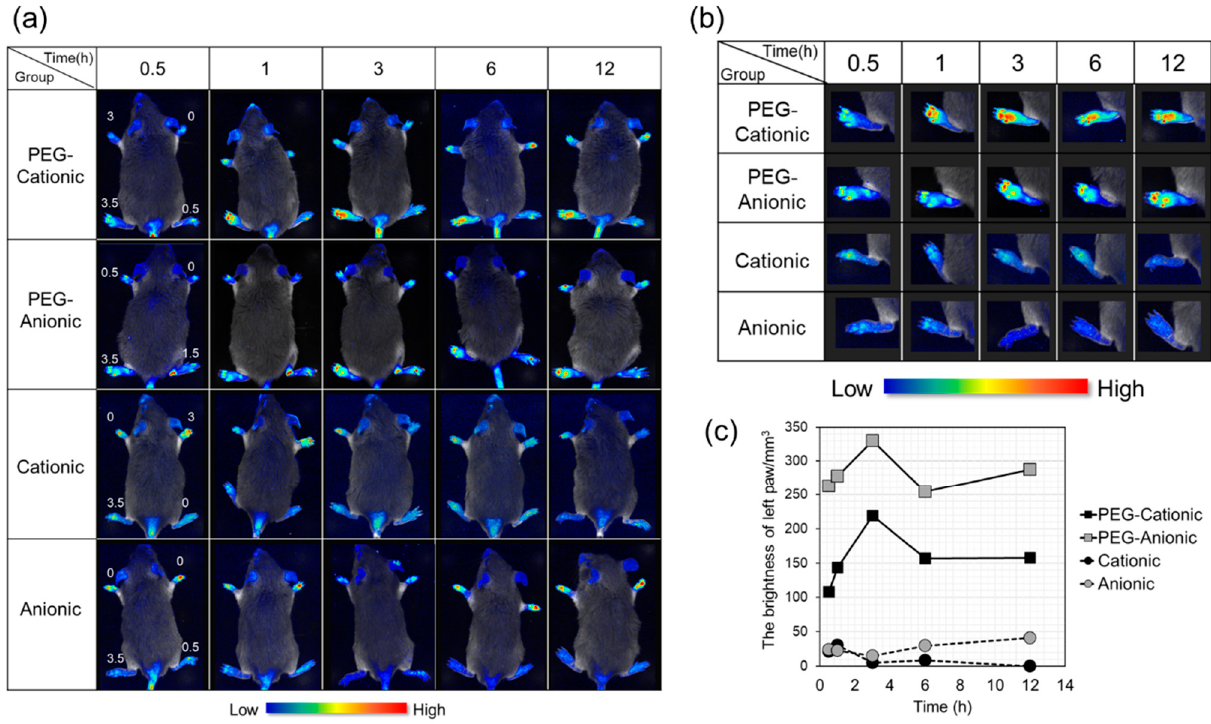
Figure 1. In vivo imaging and liposome brightness in collagen-induced arthritis (CIA) mice. CIA mice were intravenously administered four different liposome samples using Maestro TM . ( a ) Liposome accumulation in the inflammatory site. Numbers indicate clinical scores. ( b ) Extended image of the paw with clinical score = 3.5. ( c ) Brightness of left paw (clinical score = 3.5) determined by Maestro TM v. 2.4.